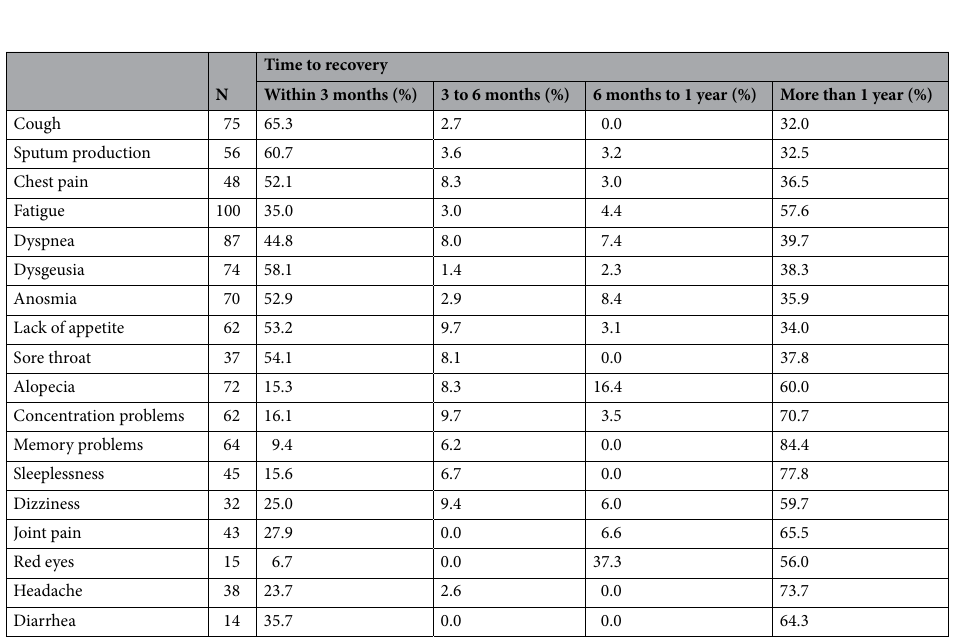
Table 3. Time to recovery of each symptom in all participants.